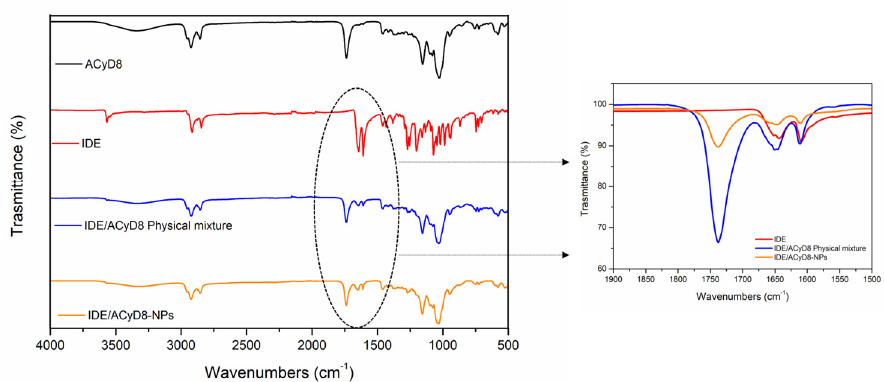
Figure 11. FT-IR spectra of IDE/ACyD8-NPs (sample C) compared to those of free components and the physical mixture. The inset shows magnification of the peaks in the range between 1750 cm −1 and 1600 cm −1 , as highlighted by the dashed ellipse.